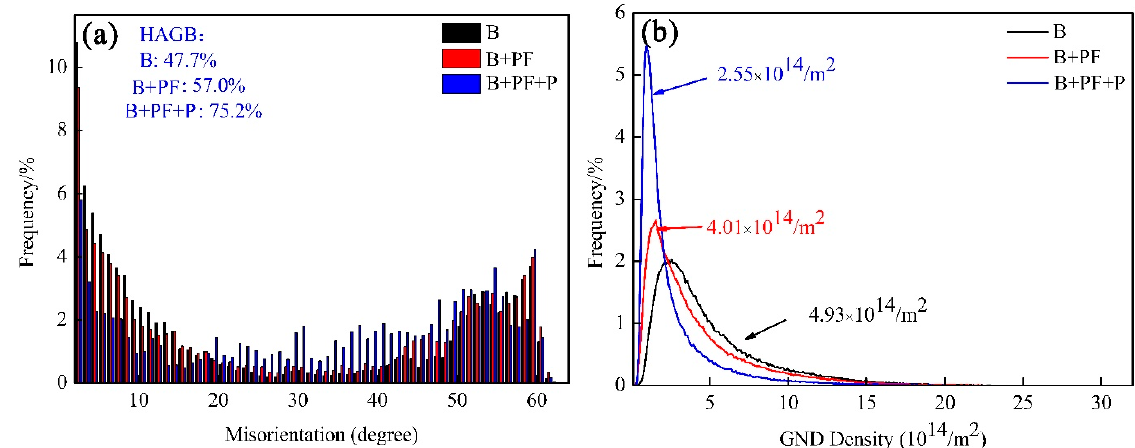
Figure 4. ( a ) The frequency of HAGBs and ( b ) GND density.